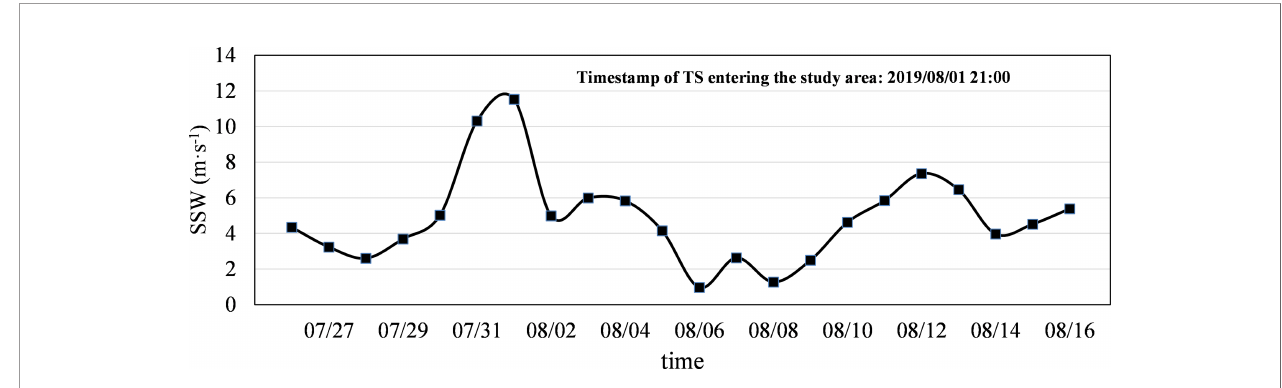
FIGURE 3 | Time series of SSW from July 26 to August 16, 2019, based on the regional average for the study region (20.5° N-22.5° N, 107.5° E-110°